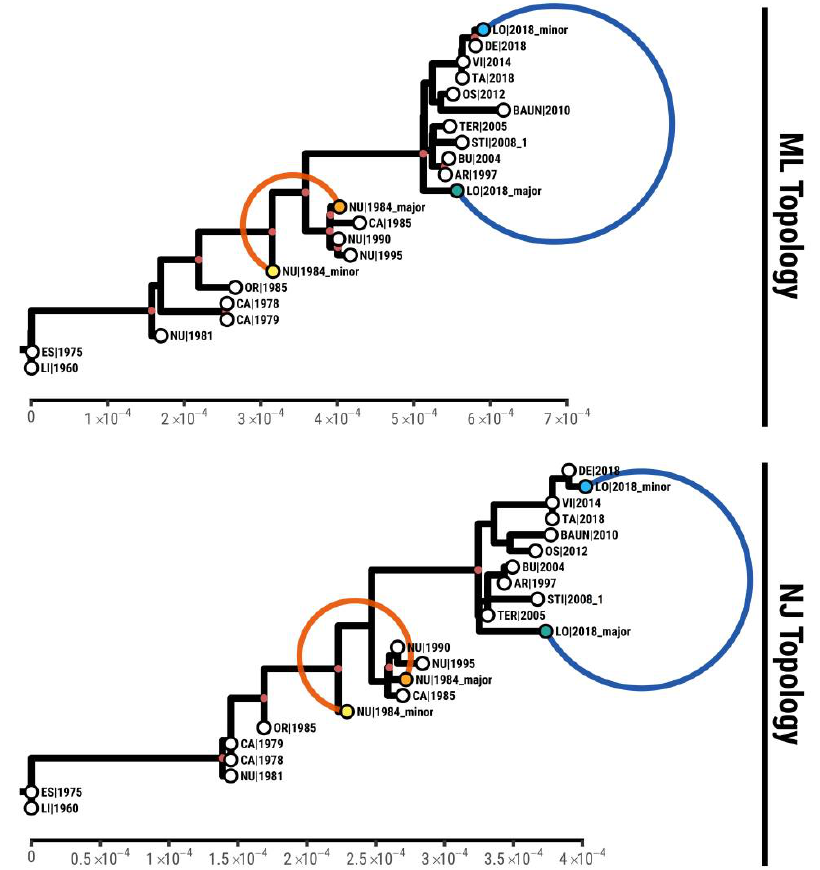
Figure 2. Maximum Likelihood and Neighbor Joining phylogenies reconstructed from Sardinian ASFV genotype I sequences. Tips characterizing the dual infections are represented in blue (LO|2018) and orange (NU|1984). Nodes with supported bootstrap values of >90 are colored in red.